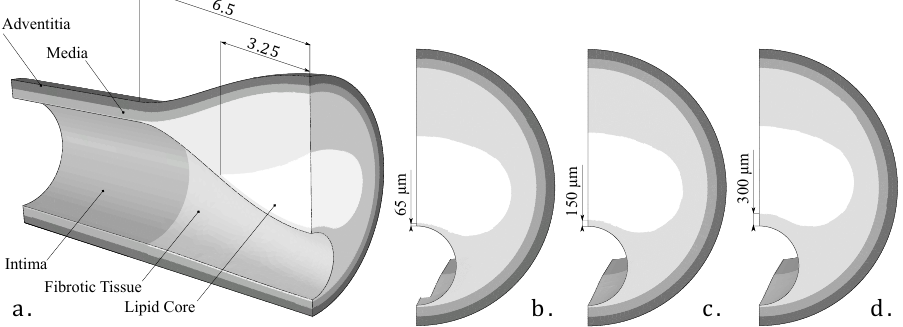
Figure 2. ( a ) 3D Idealized geometry; ( b ) fibrous cap thickness of 65 microns; ( c ) fibrous cap thickness of 150 microns; ( d ) fibrous cap thickness of 300 microns.